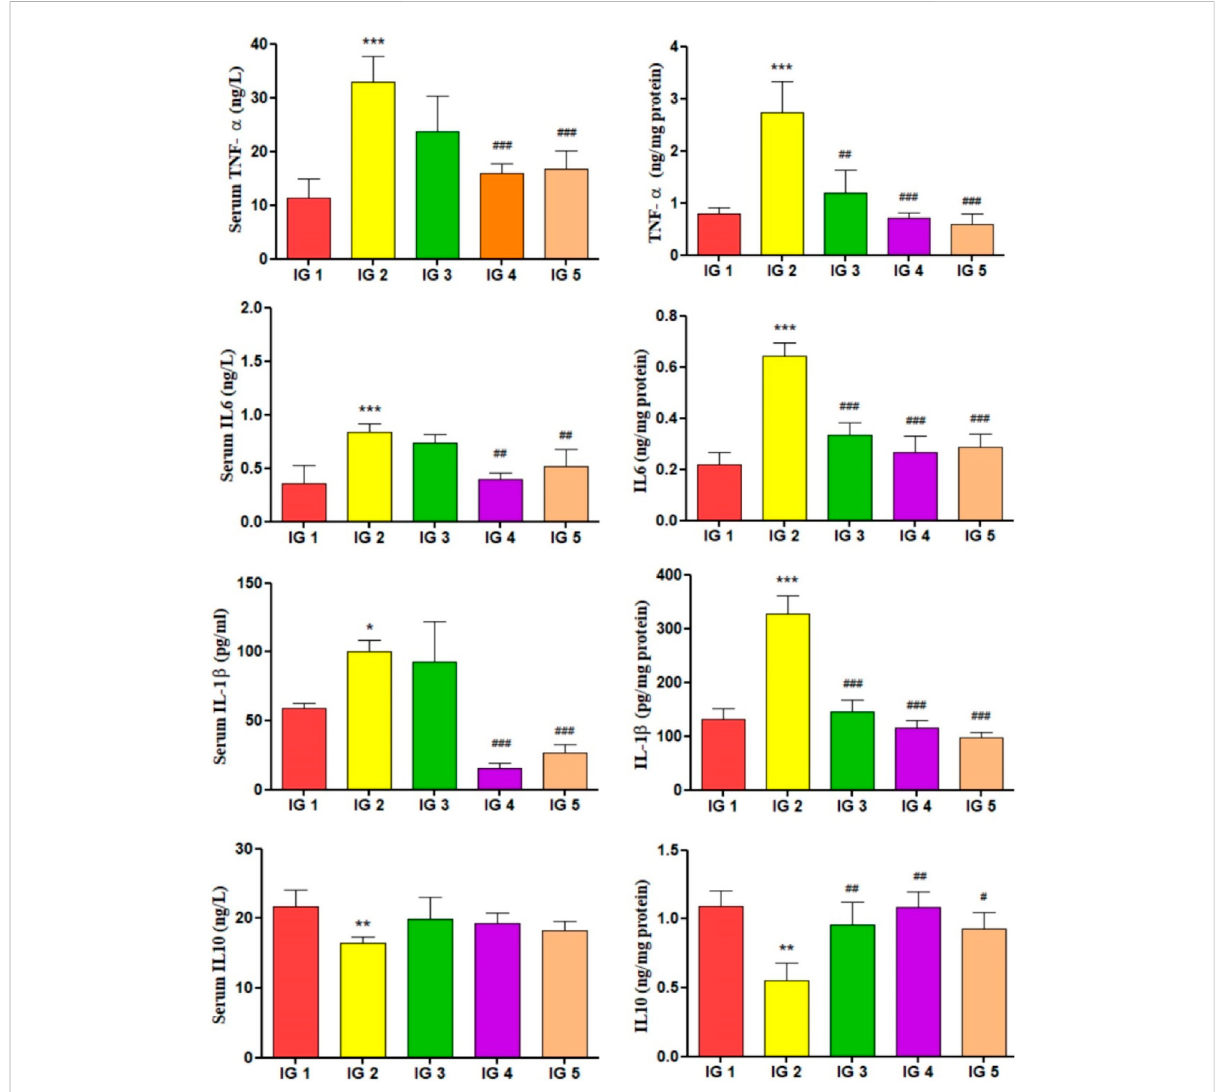
FIGURE 9 The effect of ISO and GC pretreatment on the in fl ammatory cytokines IL-6, TNF- α , IL- 1 β , and IL- 10 levels in the myocardial tissue extracts of the experimental groups. Results are expressed as mean ± SD for groups of three observations, statistically signi fi cant at *** p < 0.001, ** p < 0.01,